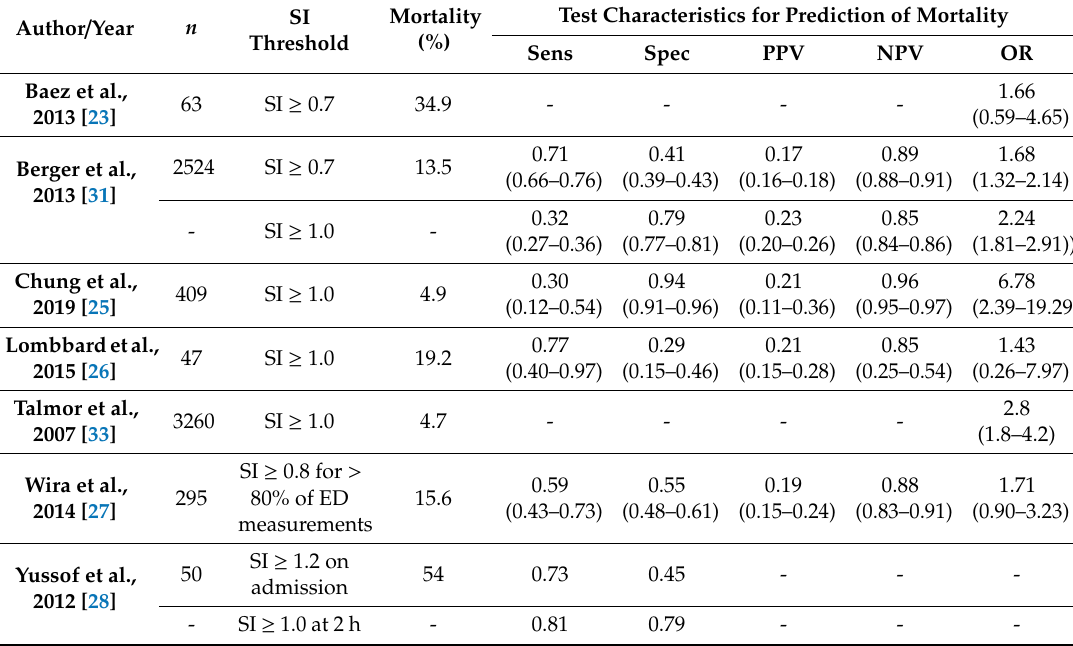
Table 2. Association between SI and mortality in patients with